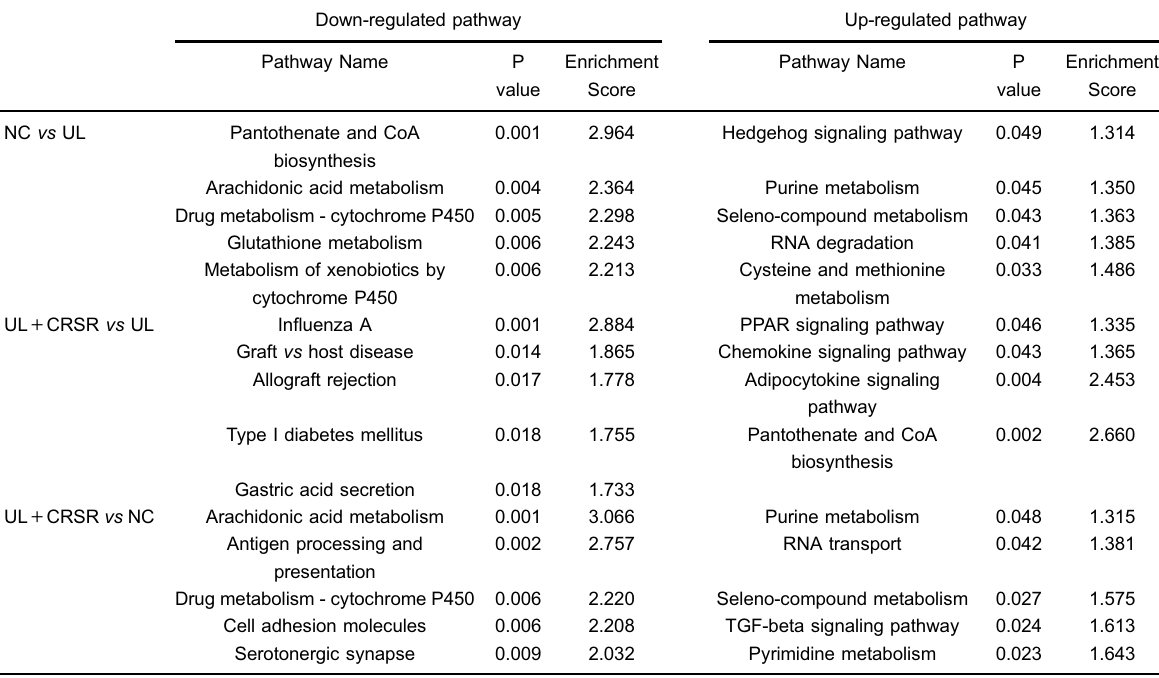
Table 3. Top fi ve differentially expressed pathways identi fi ed by Ingenuity Pathway